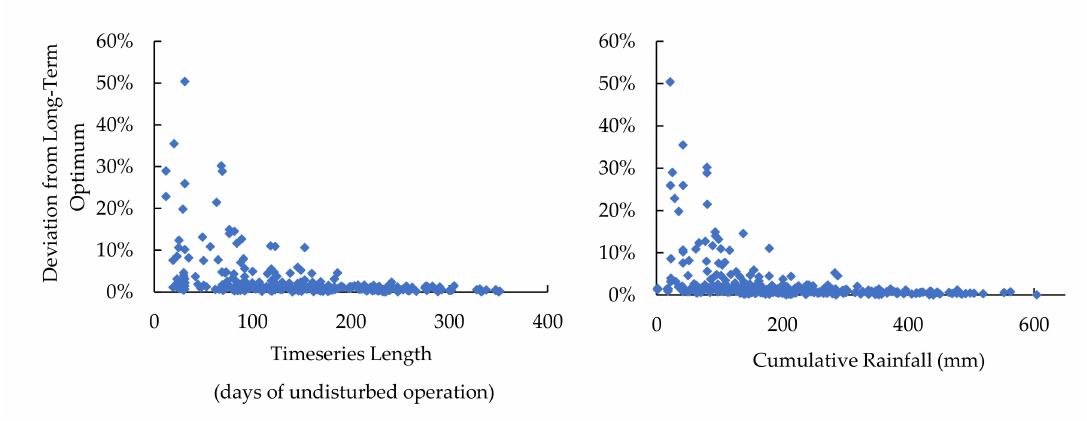
Figure 10. Deviation of the minimum emitted volume using long-term (four year) time series as input for optimization from optimization results using shortened time series.